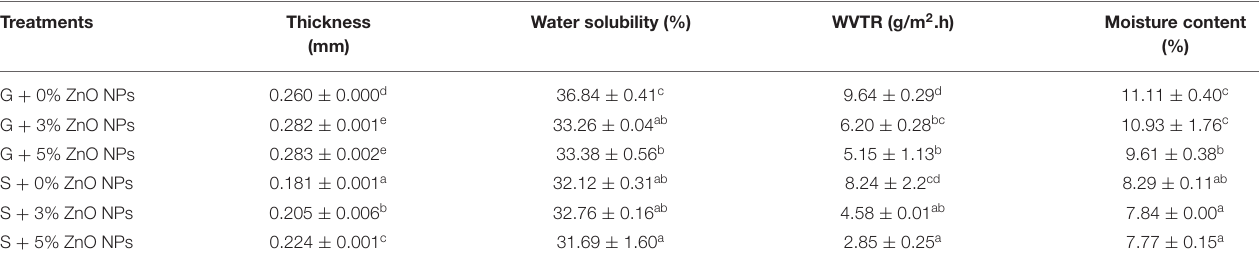
TABLE 2 | The thickness, water-solubility, WVTR, and moisture content of bionanocomposite films.